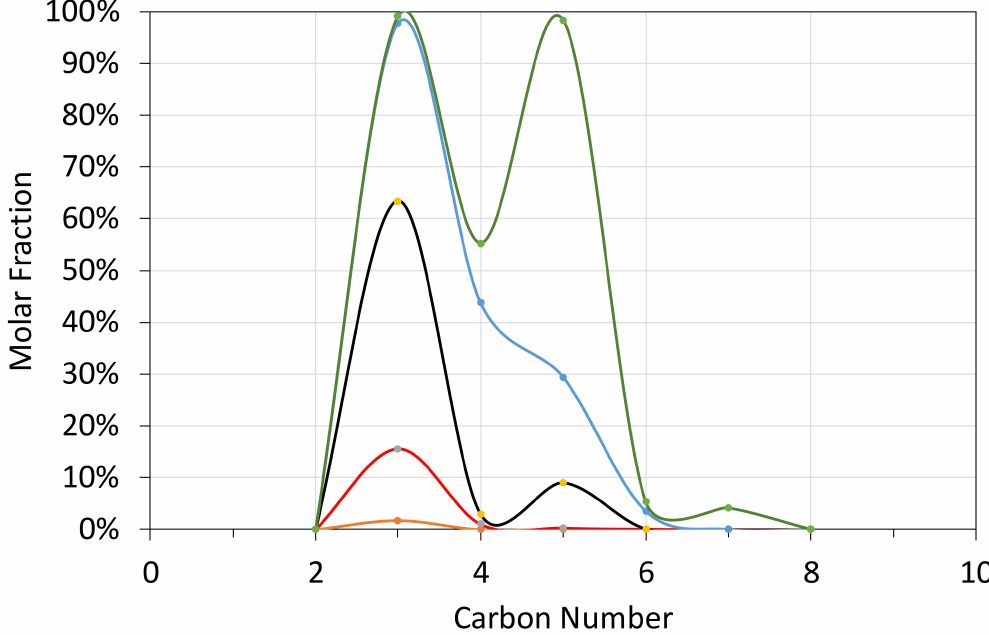
Figure A2. Molar Gas Composition Probability Distribution as a function of carbon number T = 348 K;. brown line = minimum value (0%); red line = first quartile value (25%); black line = median value (50%); blue line = third quartile value (75%); green line = maximum value